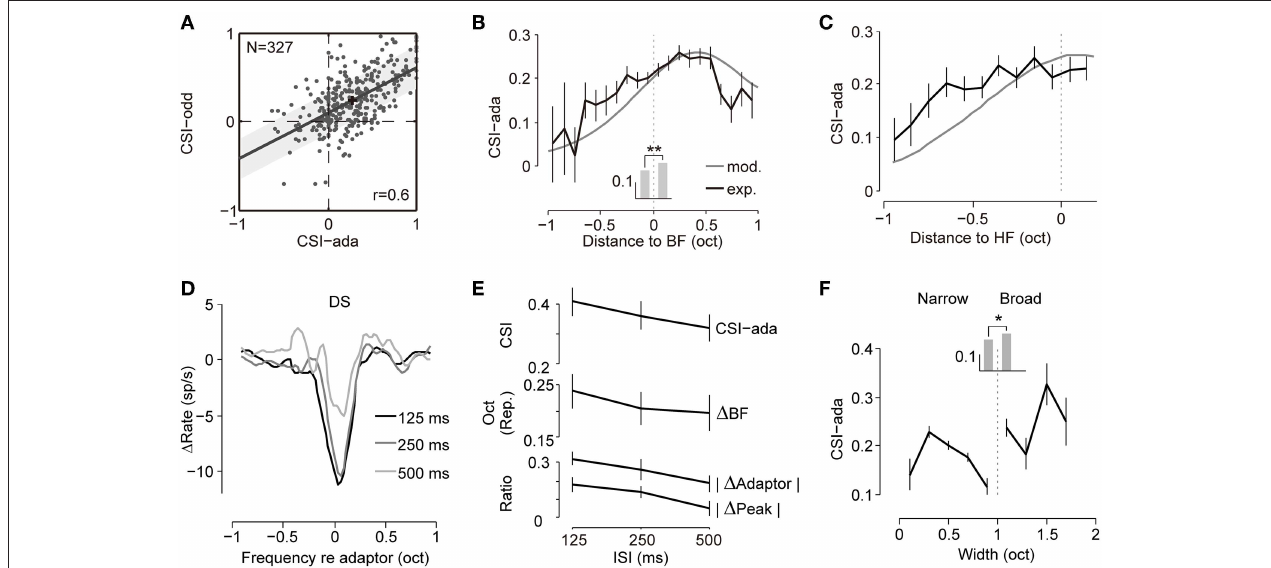
FIGURE 5 | The adaptive frequency response predicts the SSA. (A) Scatter plot showing CSIs measured with a biased ensemble (CSI-ada) and oddball sequence (CSI-odd) were significantly correlated (Pearson’s r = 0.602 , p = 1 . 25 × 10 − 33 ). The best-fit linear regression line is shown (least square, slope = 0.52). The shadow bounds the 95% confidence interval. The black cross represents the mean value of the dot clusters. (B) Averaged CSIs (CSI-ada) calculated from both adapted tunings (black) and the model (gray) as functions of the center of the tested frequency pair (relative to the BF). The curve from the model (maximal value: 0.61) was rescaled to match the maximal value of the curve from the experiment (0.26) for display only. Mean CSIs at frequencies below and above the BF are displayed as bars in the middle. The asterisks indicate that CSIs in the high-frequency group were significantly larger than in the low-frequency group (Wilcoxon rank sum test, p = 1 . 5 × 10 − 4 ). (C) CSIs were grouped according to the frequencies relative to the high-frequency (HF) edge of each cell. Higher CSI values are clearly skewed toward the higher edge. The same conventions as in (B) . (D) Averaged DSs under three ISIs (125, 250, and 500ms, coordinated to the adaptor before averaging, n = 48 ) showing greater local suppression under a shorter ISI. (E) The dependence of CSI-ada (top), BF repulsive shift magnitude ( 1 BF , middle), suppression magnitude of the peak (| 1 R peak |, bottom) and adaptor response (| 1 R f = adaptor |, bottom) on the ISI. It displayed a trend of decreasing effect with increases in the ISI. Spearman’s correlation between ISIs and the parameters are -0.08, -0.04, -0.13, -0.15 for CSI-ada, 1 BF , | 1 R peak |and | 1 R f = adaptor |respectively. (F) Dependence of CSI-ada on the bandwidth. The mean values for narrowly and broadly tuned neurons are compared as bars in the middle. Asterisk shows that broadly tuned neurons exhibited higher SSA degrees (Wilcoxon rank sum test, p = 0.038 ). All error bars indicate the mean ±